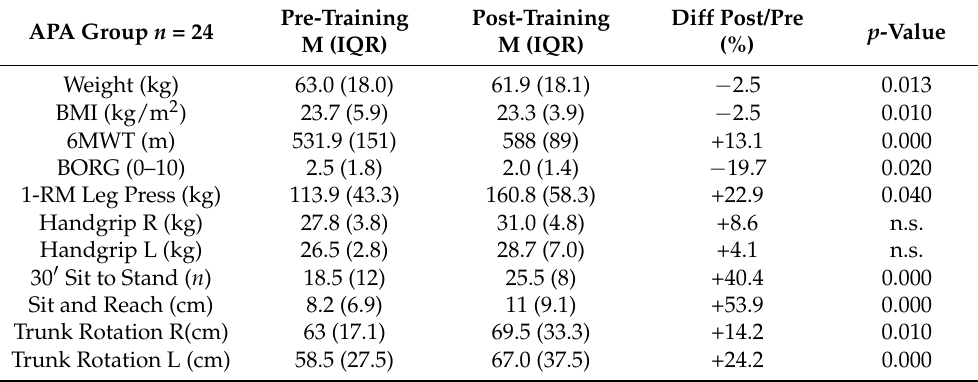
Table 4. Pre- and post-functional evaluation APA group. Abbreviation: M = Median; IQR = Interquar- tile Range Diff = Differences in percentage; n = numbers; BMI = Body Mass Index; 6MWT = Six min walking test; 1-RM = One Repetition Maximum; R = right; L = left; n.s. = no statistical significance.